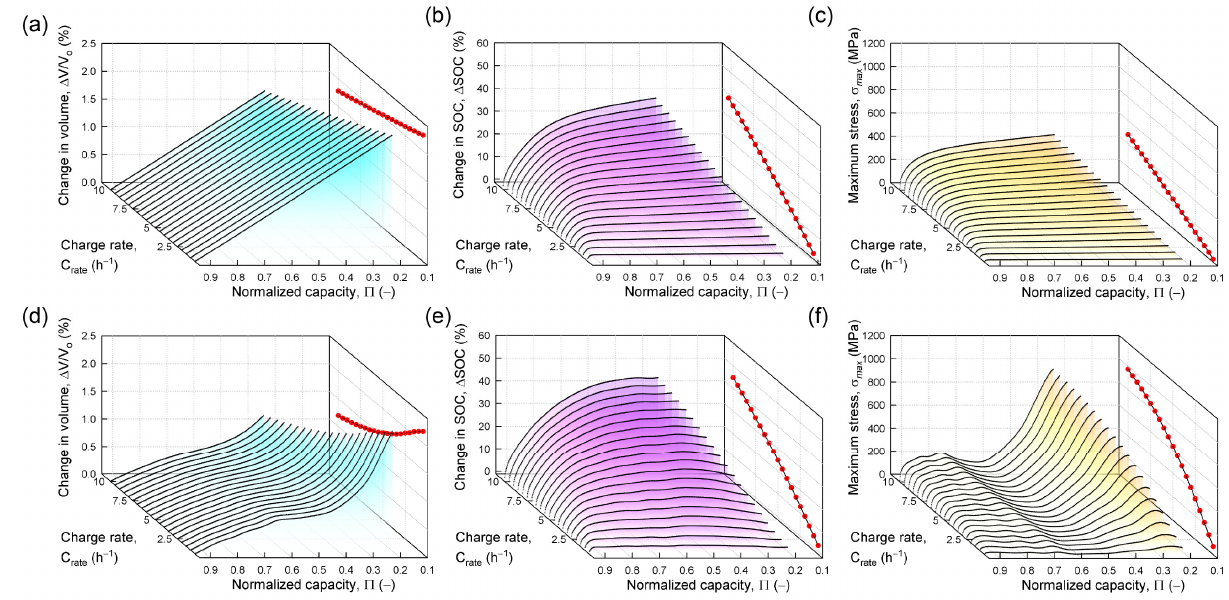
Figure 10. Impact of the charging rate (C rate ) on the transient chemomechanical response during the delithiation process. The results ( a – c ) were obtained using a constant partial molar volume, and the results ( d – f ) were obtained using a variable partial molar volume. The red dots to the right of each graph denote the evolution of the respective peak values. ( a , d ) Evolution of volume change ( ∆ V/V o ) of the particle size. ( b , e ) Evolution of the maximum difference in this state of charge ( ∆ SOC). ( c , f ) Evolution of the first principle maximum stress ( σ max ) in the active